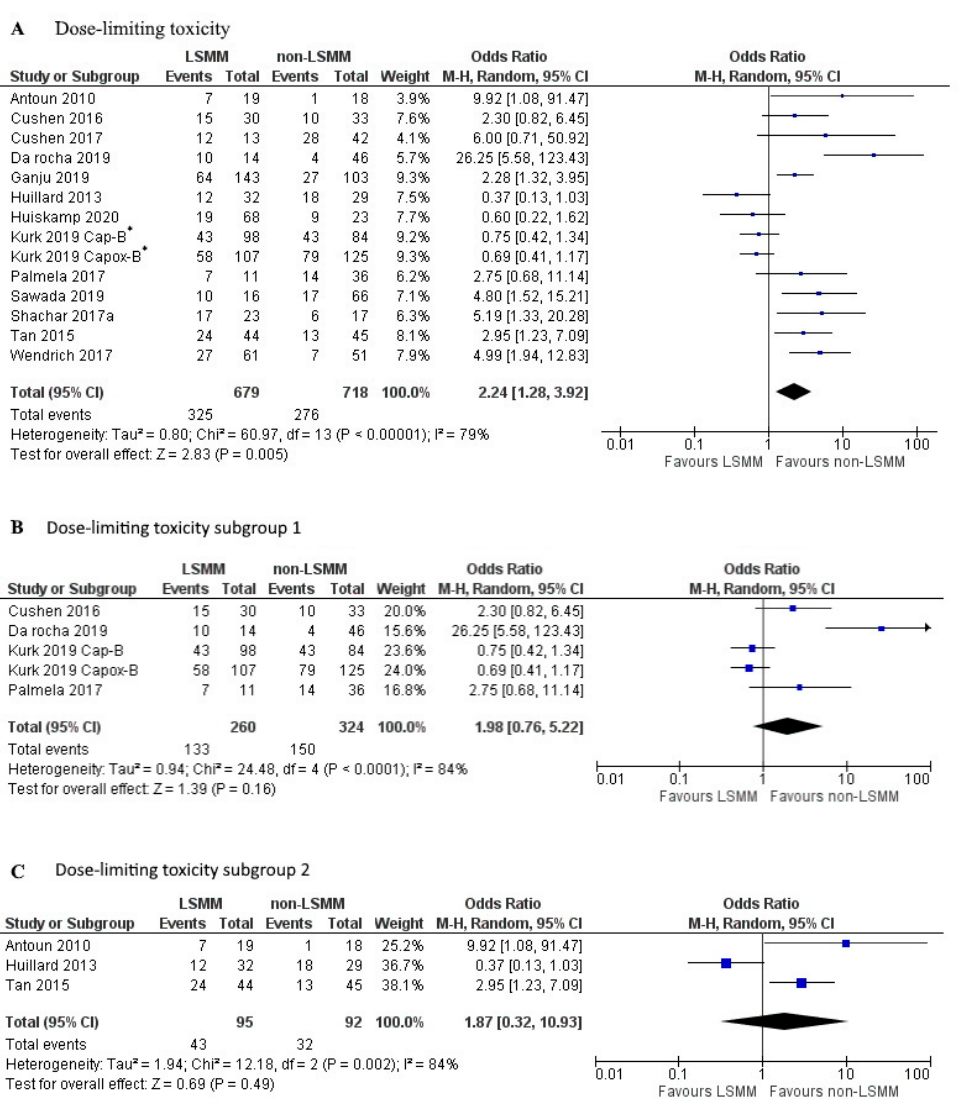
Figure 3. Forest plots for the association between low skeletal muscle mass (LSMM) and the odds to develop anti-cancer drug toxicity, specifically dose-limiting toxicity (DLT). ( A ) shows the odds to develop toxicity for all included studies with DLT as the toxicity endpoint. ( B ) shows the odds to develop DLT for a selected group of studies that besides the same toxicity endpoint also share the same cut-o ff value established by Martin et al., 2013 [46], as well as the same measurement technique using CT at the L3 vertebrae. ( C ) shows the odds to develop DLT for a second selected group of studies that share the same cut-o ff value established by Prado et al., 2008 [45], as well as the same measurement technique using CT at the L3 vertebrae. For each forest plot, the combined e ff ect of the studies is plotted with a black diamond. * The patient population in the study by Kurk et al., 2019, received sequential treatments. The odds ratio was determined for each treatment separately and therefore entered separately into the forest